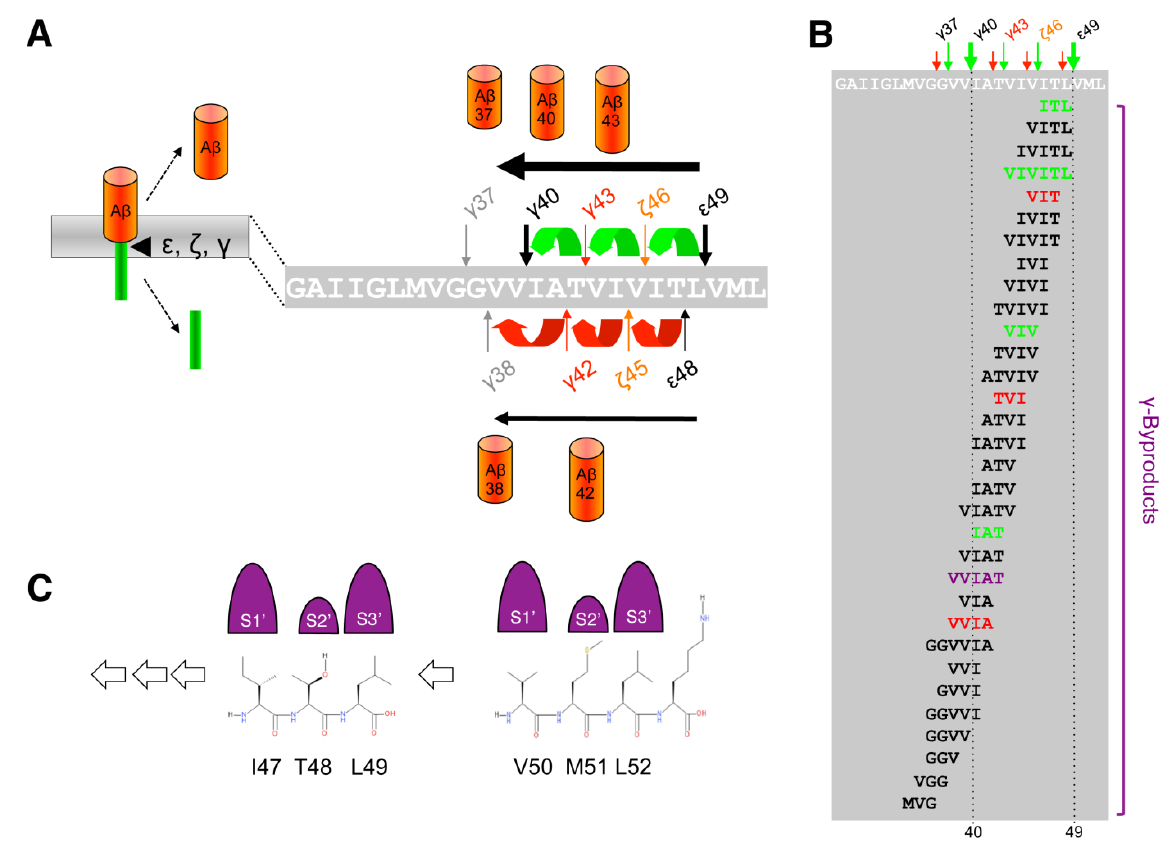
FIGURE 4: Stepwise cleavage model of APP. (A) The two product lines leading to the generation of Aβ40 and Aβ42 are depicted. In the major product line Aβ40 is generated by consecutive tripeptide - releasing cleavages (green) at the ε - 49, ζ - 46 and γ -43 sites. In a minor product line, Aβ42 is generated in a similar manner by consecutive cleavages (red) at the ε - 48 and ζ -45 sites. (B) Besides γ -byproducts from the two main product lines (green and red) including a hexapeptide resulting from direct cleavage of Aβ49 to Aβ43, multiple additional minor peptides have been identified suggesting multiple product line crossings. The pentapeptide resulting from cleavage of Aβ43 to Aβ38 is indicated in purple. (C) Sequential cleavage continuously requires sterically compatible interactions of P2´ residues with the S2´ enzyme subsite of γ -secretase; major product line shown. The adjacent P4´ residue K53 is additionally presented for the comparison of side chain